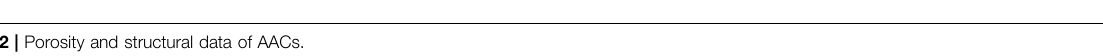
TABLE 2 | Porosity and structural data of AACs.